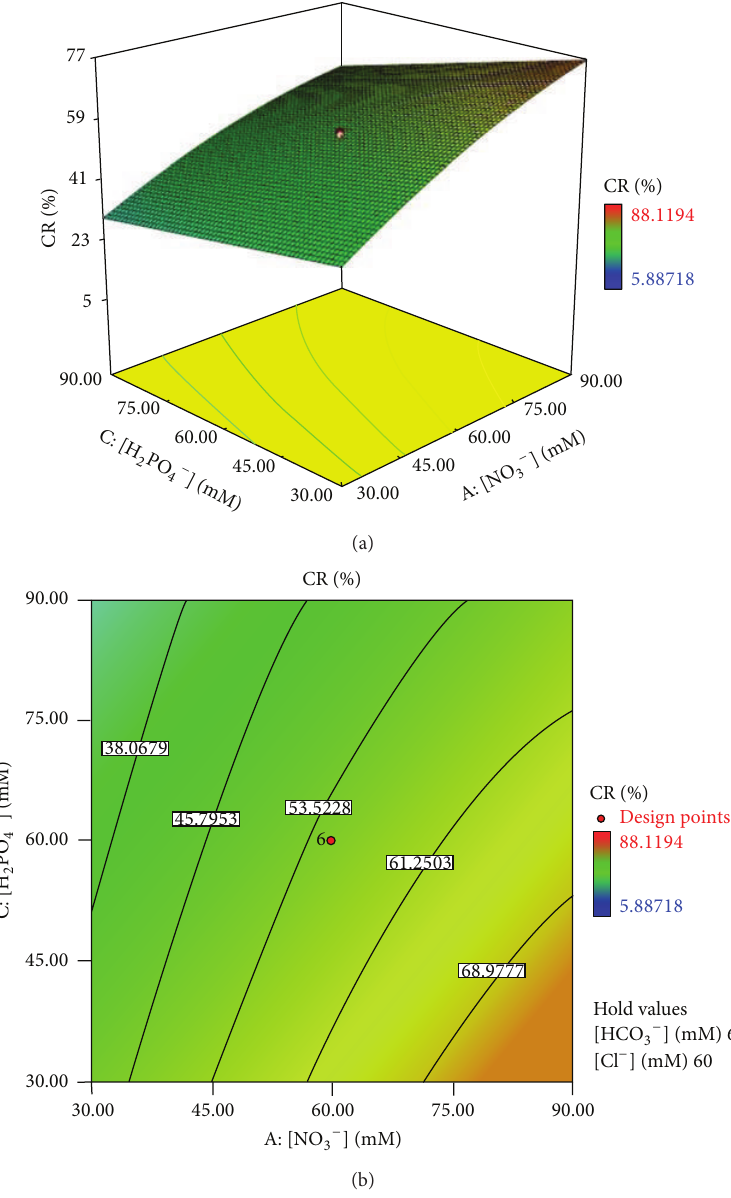
Figure 4: Response surface (a) and contour plots (b) of the removal efficiency (%) as a function of NO 3− and H 2 PO 4− concentration.